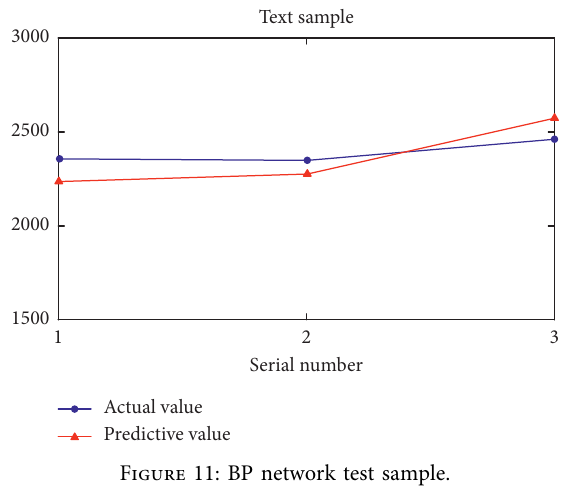
Figure 11: BP network test sample.